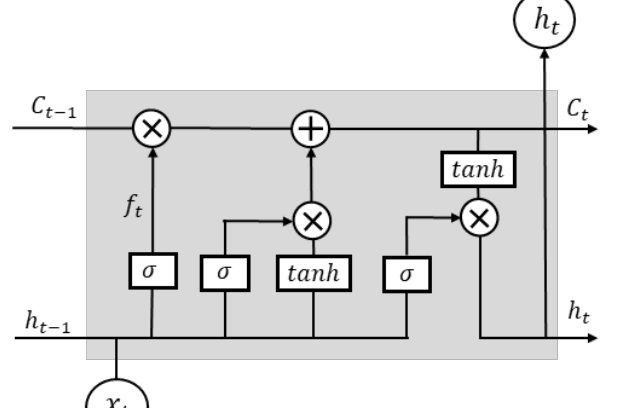
Figure 11. LSTM unit.